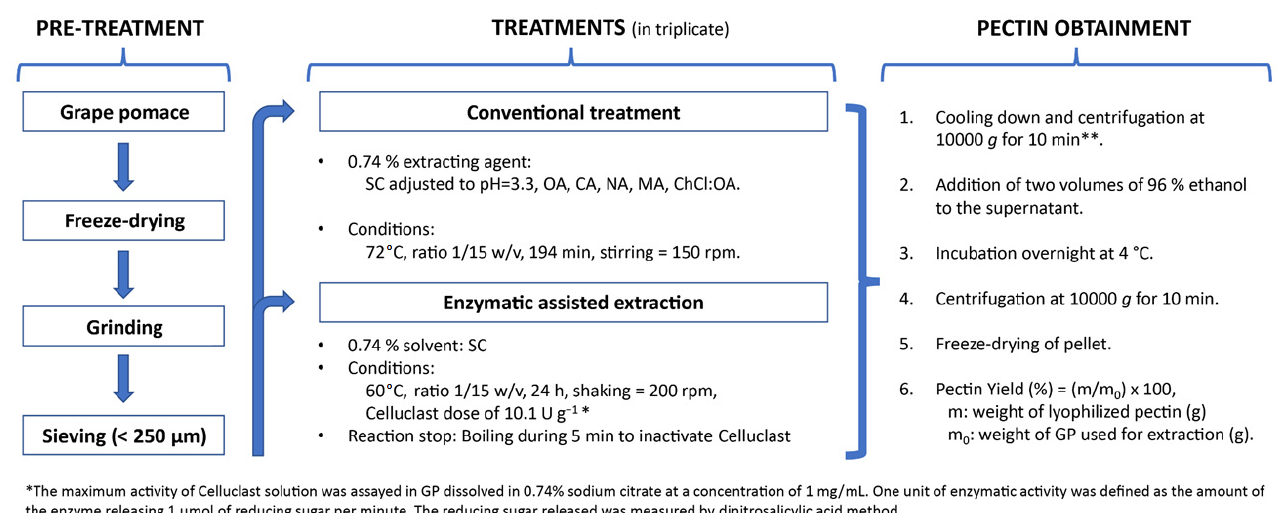
Figure 1. Overview of the different treatments and conditions. SC, sodium citrate; OA, oxalic acid; CA, citric acid; NA, nitric acid; MA, malic acid.